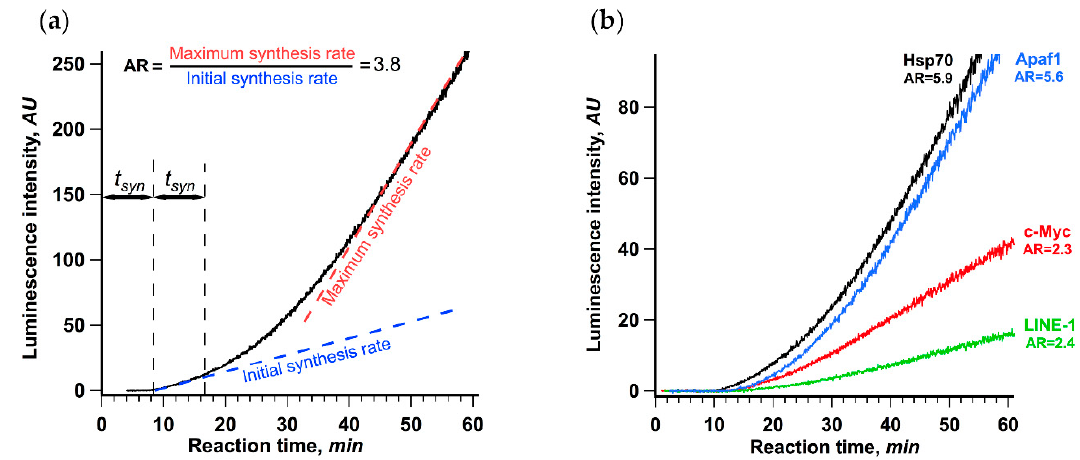
Figure 1. Rate of protein synthesis increases in the course of translation of capped and polyadenylated mRNA, as revealed by continuous in situ measurement of luminescence. ( a ) β gloFlucA50 mRNA (25 nM) was translated in a Krebs-2 cell-free translation system at 30 °C. The dashed lines depict the initial synthesis rate as the slope of the linear fit of the data collected during the first 5 min after the appearance of active product and the maximum synthesis rate as the maximum slope of the kinetic curve achieved in the course of translation reaction. The ratio of the maximum and the initial synthesis rates was used as a measure of the translation acceleration (AR, stands for “acceleration rate”). The initial translation rate was determined as a linear approximation of a 5 min fragment of a kinetic curve right after appearance of luciferase activity; maximum translation rate was determined as a maximal value of the slope of linear approximations obtained for a 5 min window sliding along the whole kinetic curve with 2.5 s step. ( b ) Four Fluc encoding mRNAs with 5 ′ untranslated regions (UTRs) of different human genes (HSPA1A, 5 ′ UTR is 219 nt long; MYC, 421 nt; APAF1, 580 nt; and LINE-1, 908 nt) were translated in the same system. In both cases, the representative curves out of at least three replicates are shown.